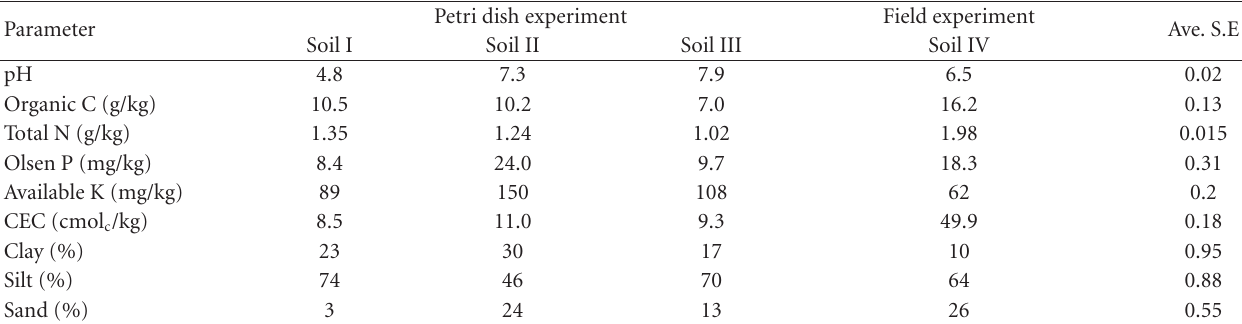
Table 1: Chemical and physical properties of the soils used in Petri dish incubation and field experiments.